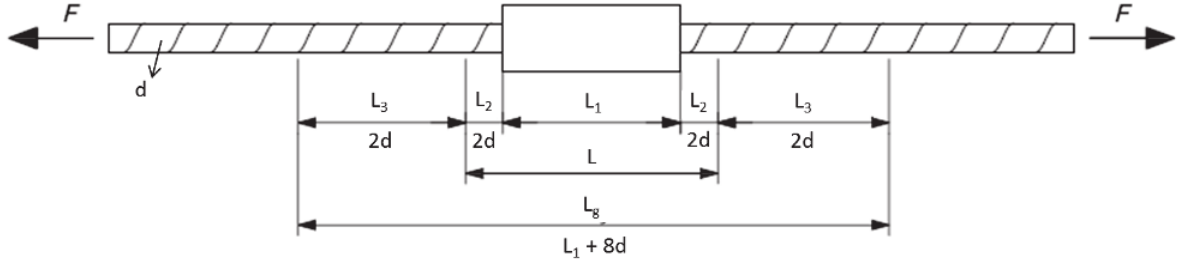
Dimensions of sample to test mechanical splice performance, modified from ISO 15835